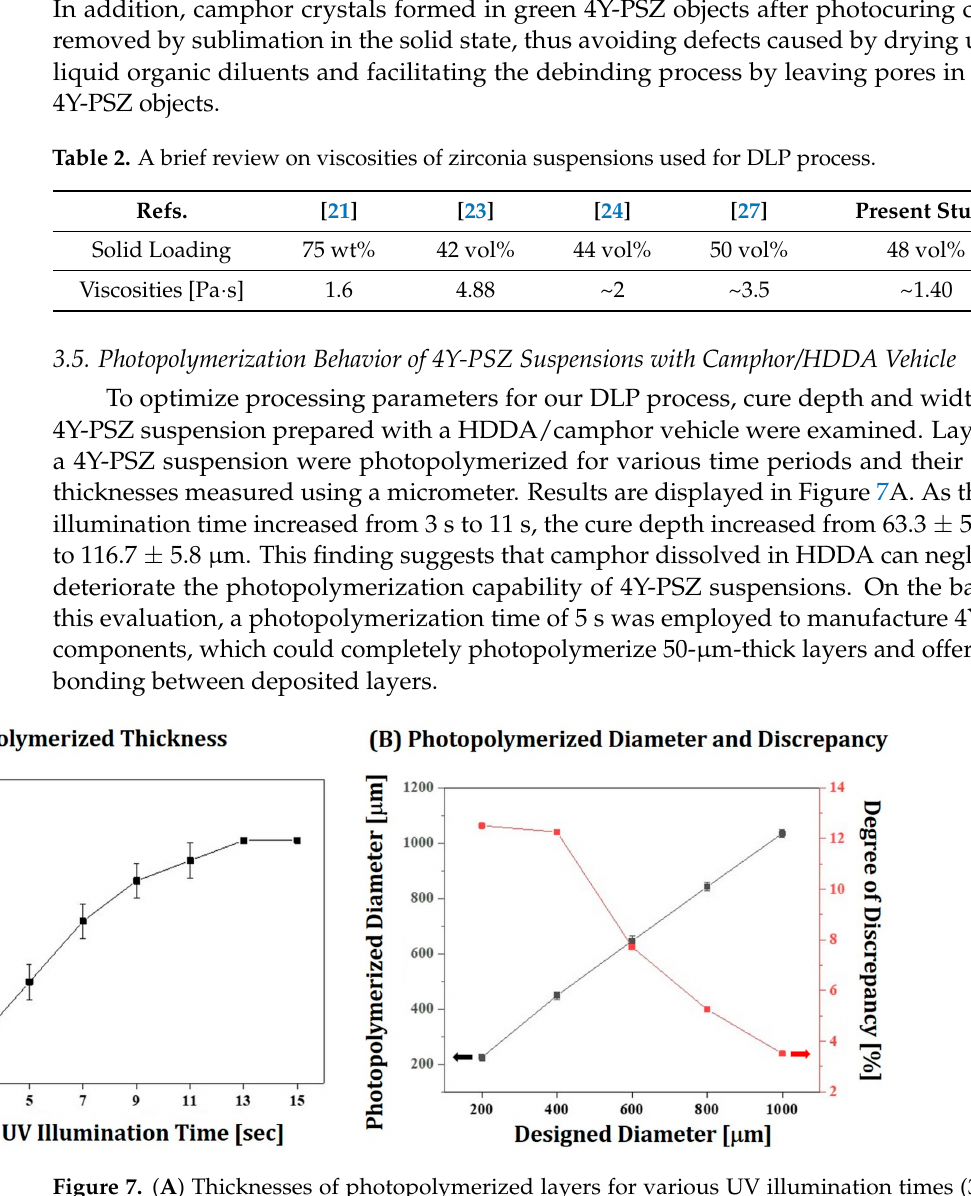
Figure 7. ( A ) Thicknesses of photopolymerized layers for various UV illumination times (3–15 s) and ( B ) diameters of photopolymerized disks according to designed diameters and discrepancy in relation to designed diameters.